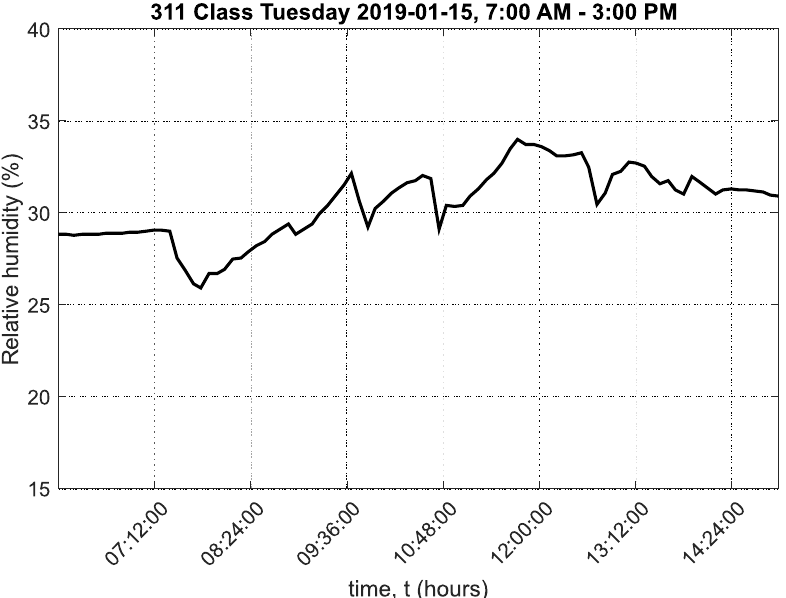
Figure A3. Graph of ambient temperature in classroom 311, Frenštát pod Radhoštˇem.